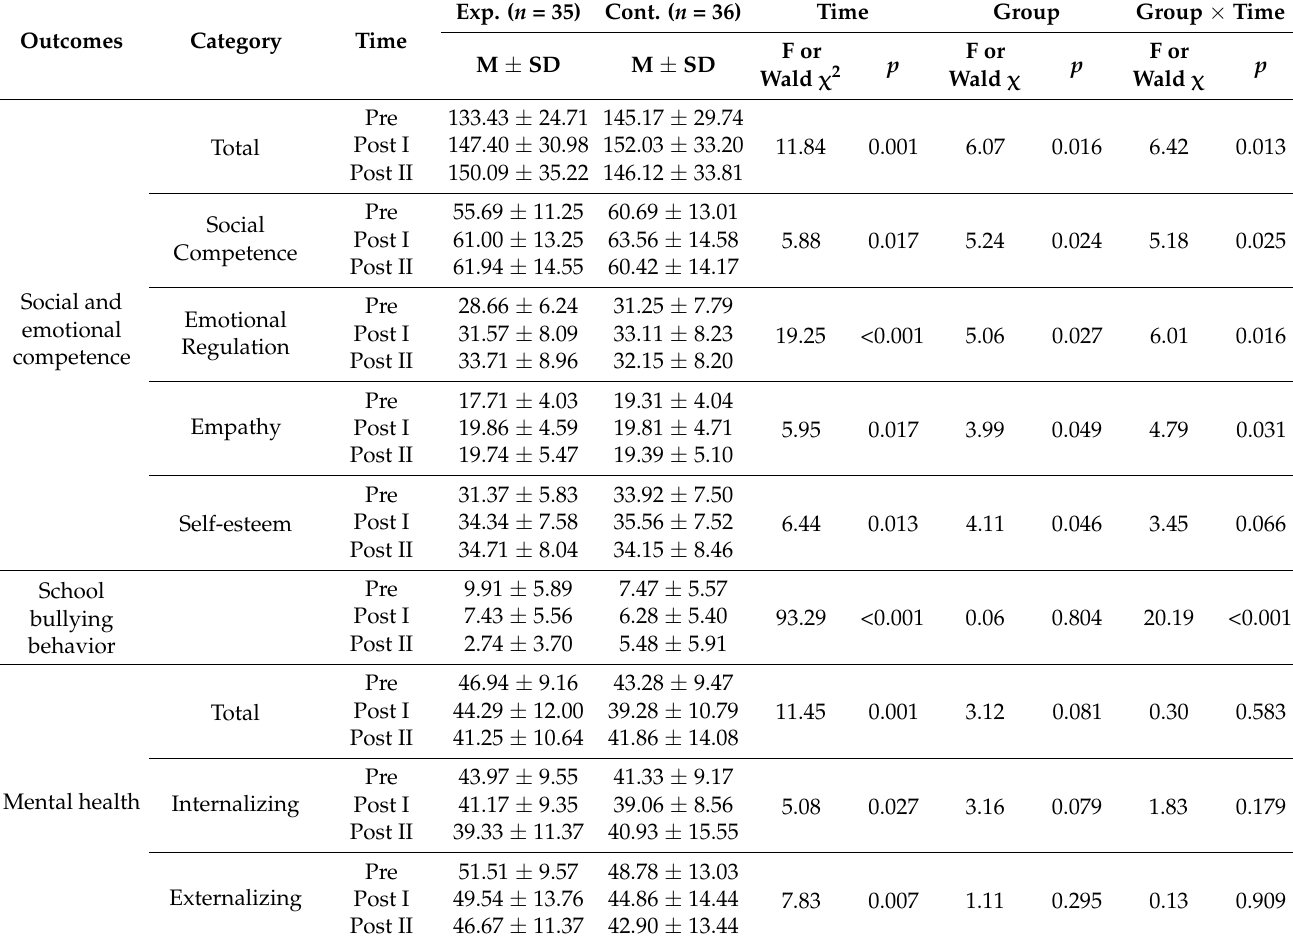
Table 3. Intervention effects on dependent variables ( n =